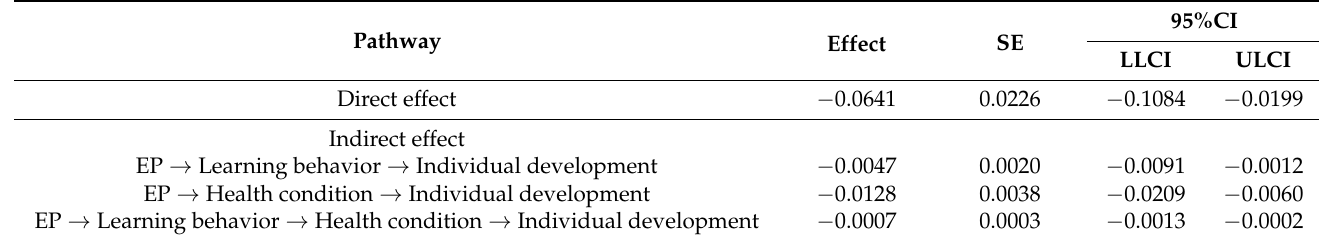
Table 3. The serial mediating effects analysis among